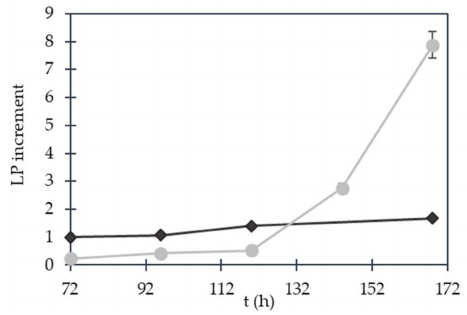
Figure 3. Lipopeptide production increment for the NBPS and NBPSHA assays. The relative percentage of increase was calculated by considering 100% of the area of the peak corresponding to 0 h of incubation time after treatment. ( ) NBPSHA; ( ) NBPS